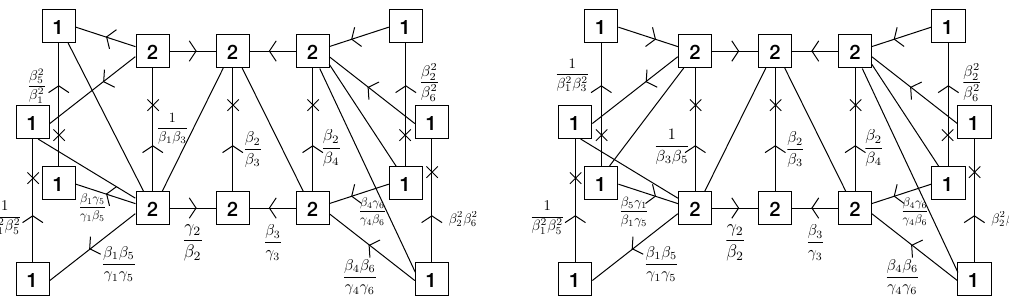
Figure 10 . Basic domain walls in the a(cid:14)ne D 6 quiver theory. The left wall is for D 1 = f + + j (cid:0) + j + + g (cid:12) and the right wall is for D 2 = f + (cid:0) j (cid:0) + j + + g (cid:12) . cubic anomalies from the 4d chiral multiplets q and ~ q given in (cid:12)gure 9. Also, the